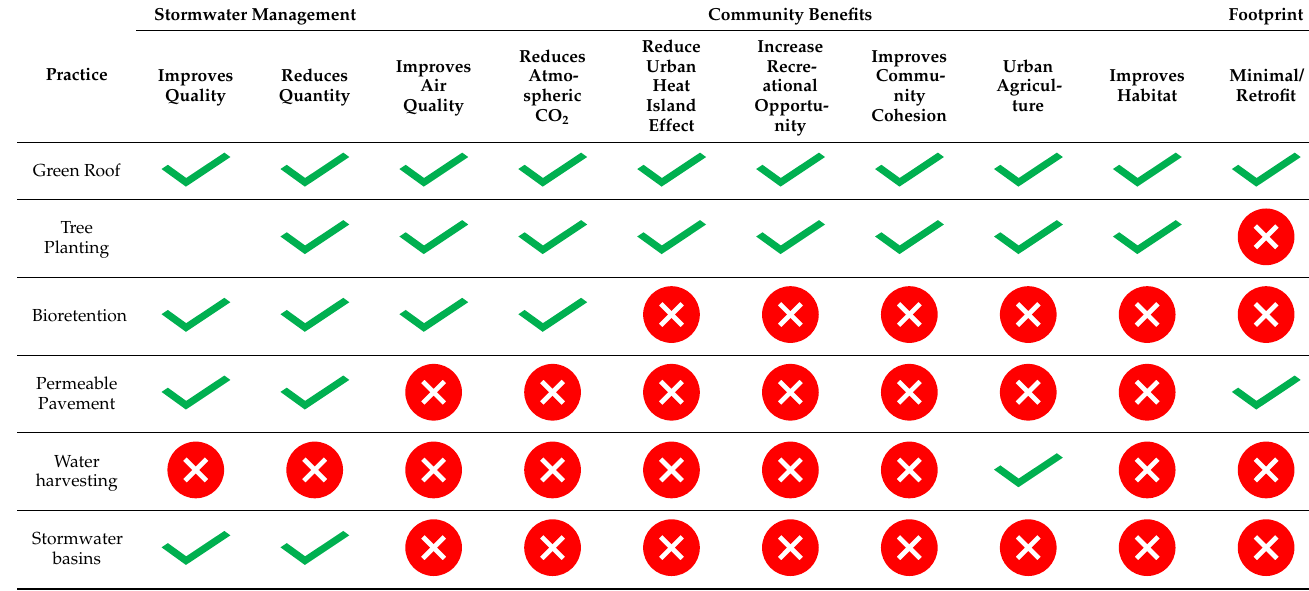
Table 1. Green infrastructure practices and benefits.